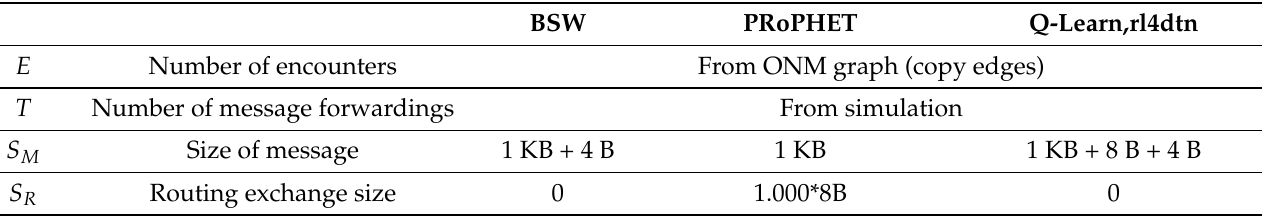
Table 3. Data exchange parameters.